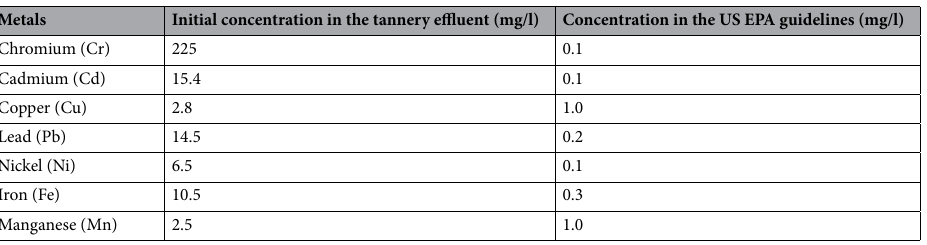
Table 3. The average concentration of heavy metals in the tannery wastewater sample before treatment.